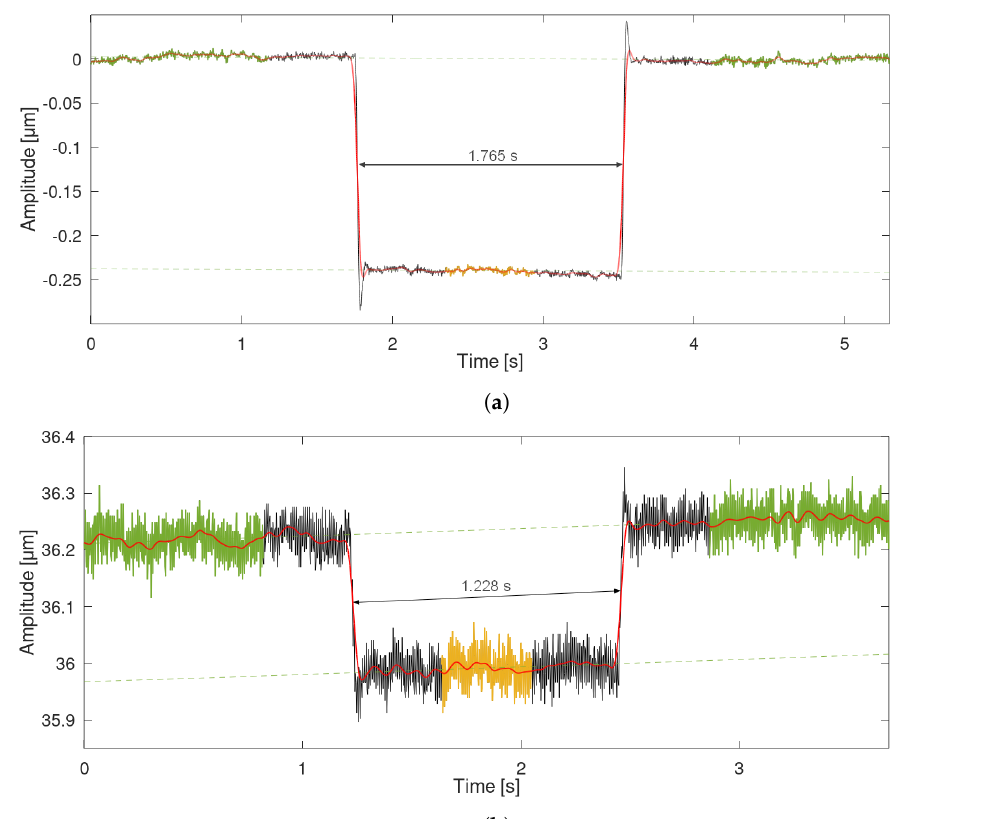
Figure 7. An example of 0.24 µ m groove acquired with: ( a ) XL-80 laser interferometer; ( b ) Taylor Hobson 130 roundness measurement machine. The red line represents the profile after filtration with a Gaussian filter (cut-off length equal to 0.1 nominal width of the groove). Green-shaded areas are placed over external measurement lengths and the orange-shaded area is placed over the central measurement length. The green dashed lines represent the model fitted according to ISO 5436-1:2000 standard. These lines are extrapolated along the time axis for visual guidance. The nominal groove widths were 1.5 s and 1 s for the interferometric and roundness instrument measurements, respectively. The actual groove widths are marked on the graphs. The groove widths and consequently the size of measurement lengths were not affected by the